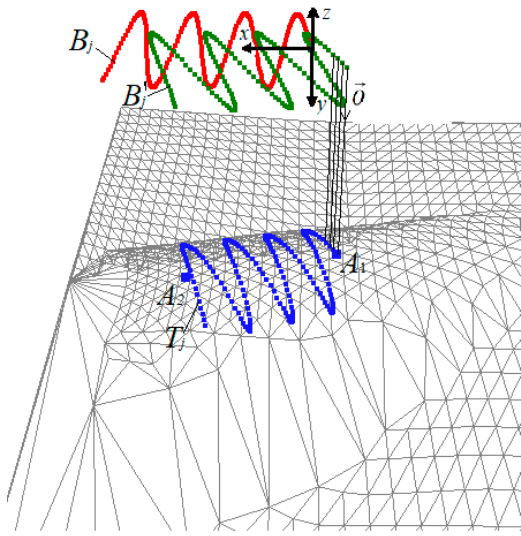
Figure 6. The desired trajectory overlaid on the surface of the underwater object.